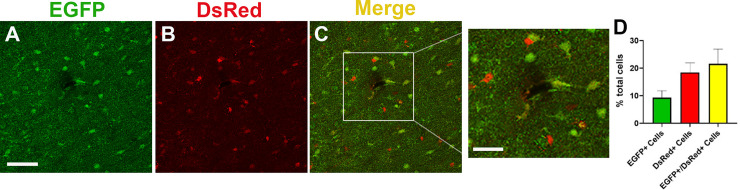
Quantitation of PAs and non-PAs within the cerebral cortices of Mlc1-EGFP;GLAST-DsRed adult mice.(A-C); Coronal brain sections through the cerebral cortices of adult Mlc1-EGFP;GLAST-DsRed mice were immunolabeled with anti-GFP antibodies (A) to visualize Mlc1-expressing cells (PAs) and anti-RFP antibodies (B) to visualize cells expressing DsRed via the Slc1a3 promoter (PAs and non-PAs). In the merged confocal image (C), note that some cells express both EGFP+ and DsRed+, whereas other cells are single positive for each fluorescent marker. Scale bar, 50 μm (A) and 10 μm (inset, C). (D); Quantification of the EGFP+ and RFP+ single positive cells as well as EGFP+/RFP+ double positive cells in the cortices of Mlc1-EGFP;GLAST-DsRed mice. Numbers of fluorescence positive cells are plotted as a percentage of total numbers of cells based on DAPI labeling, although DAPI images have not been included in this figure. Note that more than 20% of cells within the adult cerebral cortex are EGFP+ or EGFP+/RFP+, whereas non-PAs constitute approximately 20% or more of total cells. The red bars indicate DsRed+/EGFP- cell fractions.